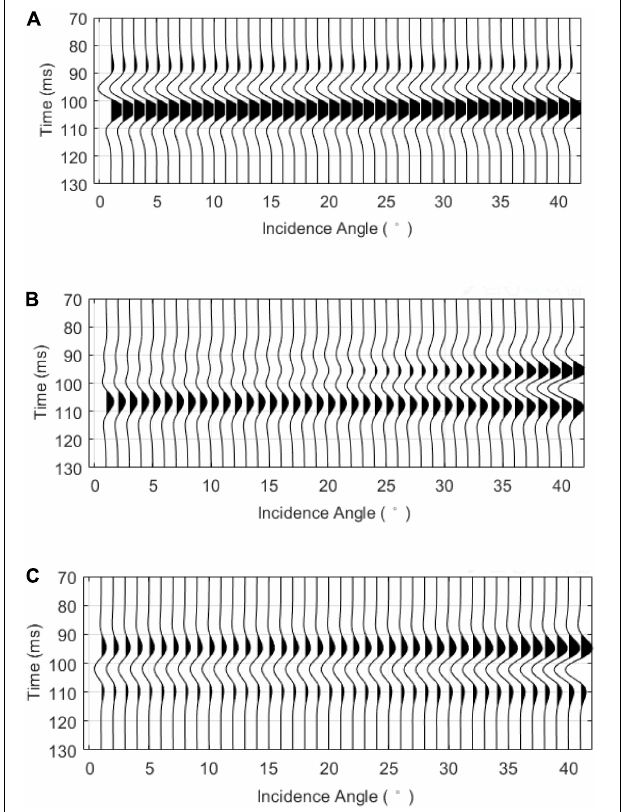
FIGURE 6 | AVO response model for gas saturations of (A) 1, (B) 0.6, and (C) 0.